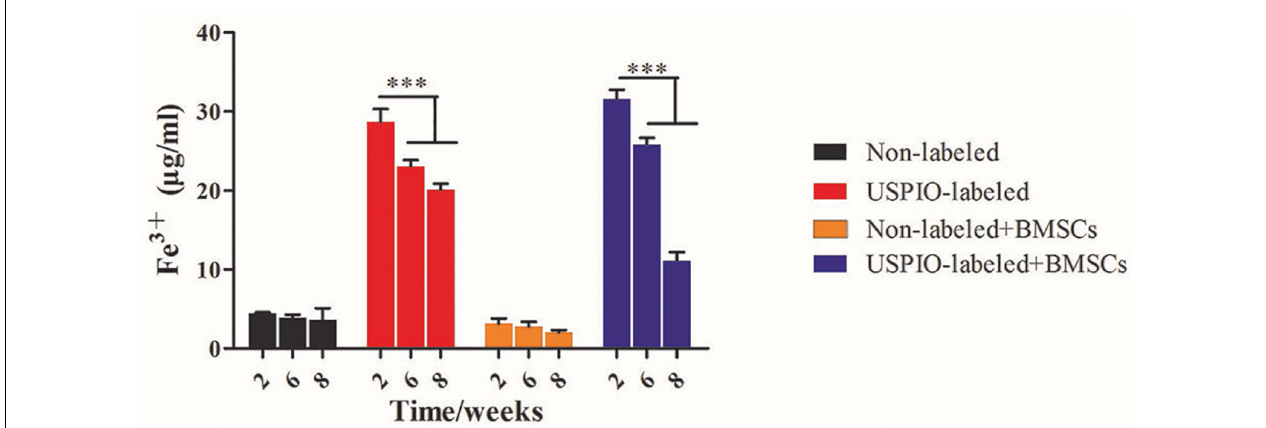
FIGURE 9 | Concentrations of Fe 3 + by ICP-MS in scaffolds decrease after implantation in vivo over time.